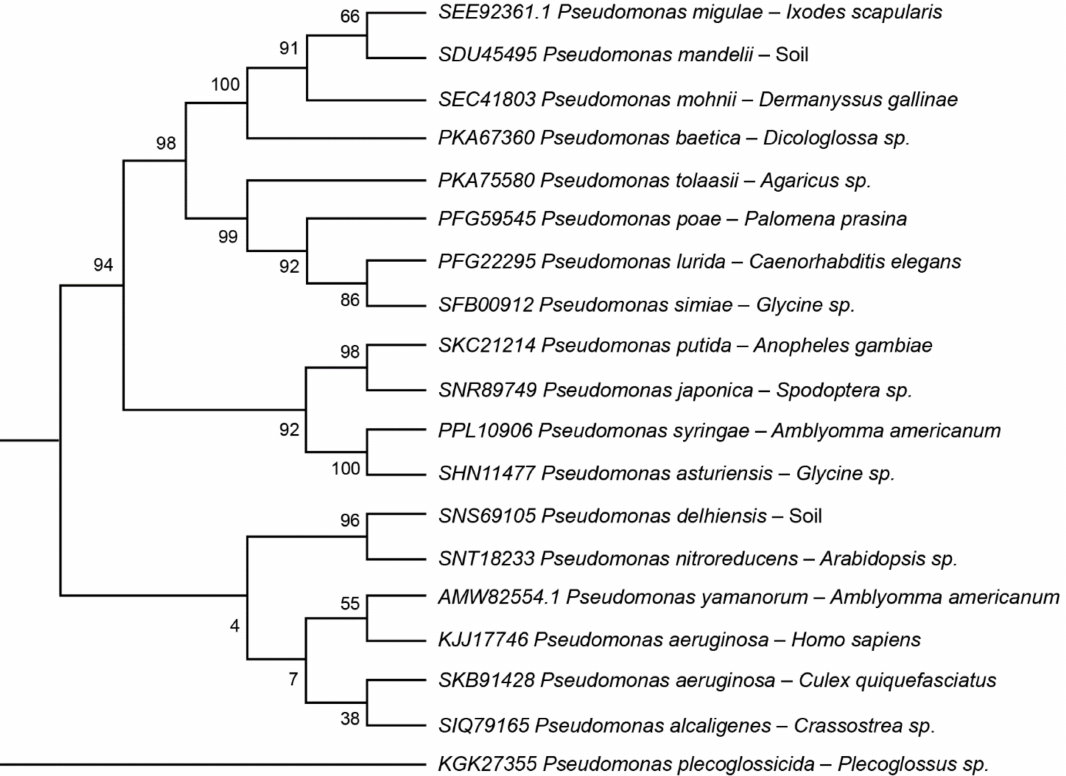
Figure 2. Comparison of the bacterial protein peptidoglycan synthetase in 19 different members of the genus Pseudomonas . Phylogenetic tree constructed using the maximum likelihood method. Accession numbers and source of isolation (i.e., vectors, hosts or environment) are